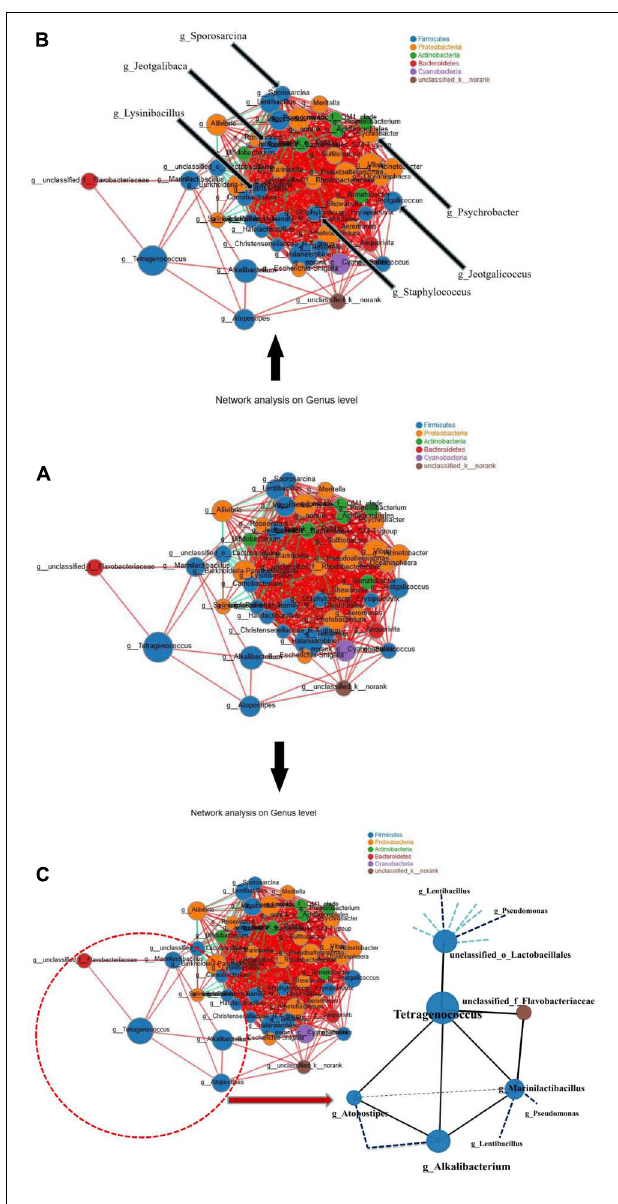
FIGURE 6 | Species relevance network map. (A) The interaction among the species in the shrimp paste samples. (B) The location of Jeotgalibaca , Jeotgalicoccus , Lysinibacillus , Sporosarcina , Staphylococcus and Psychrobacter . (C) The interaction between Tetragenococcus and its correlated genera. (The figure shows the species with p < 0.05, the absolute value of correlation coefficient ≥ 0.5; The size of nodes indicates the abundance of species, and different colors indicate different species. The red lines indicate positive correlation, while the green lines indicate negative correlation. The thicker the line, the higher the correlation between species, and the more lines, the closer the relationship between the species).